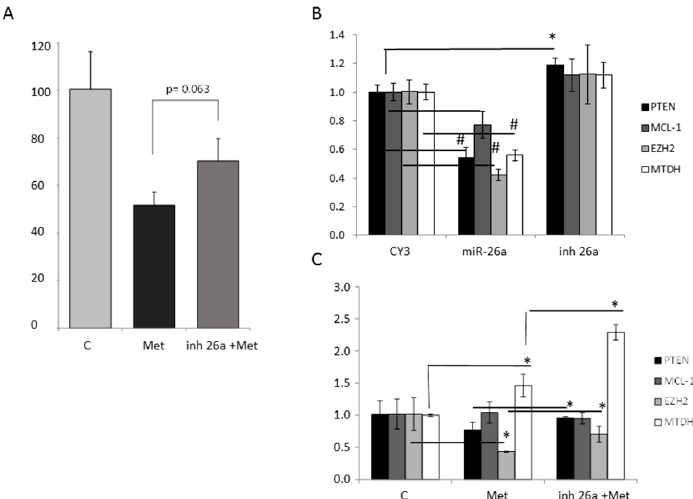
Figure 9. The effect of metformin through miR-26a on MDA-MB-231 cells. ( A ) Cell viability at 48 h after 10 mM metformin treatment with or without the miR-26a inhibitor (50 nM); ( B ) Gene expression of miR-26a targets after transfection with either 50 nM miR-26a mimetic or its inhibitor, as measured by RT-qPCR. CY3: CY3 control miRNA; ( C ) Expression of miR-26a targets measured by RT-qPCR after treatment with 10 mM metformin (in presence or not of miR-26a inhibitor) or vehicle (PBS). Error bars represent triplicate experiments. (Student t test: * p < 0.05; # p < 0.001).